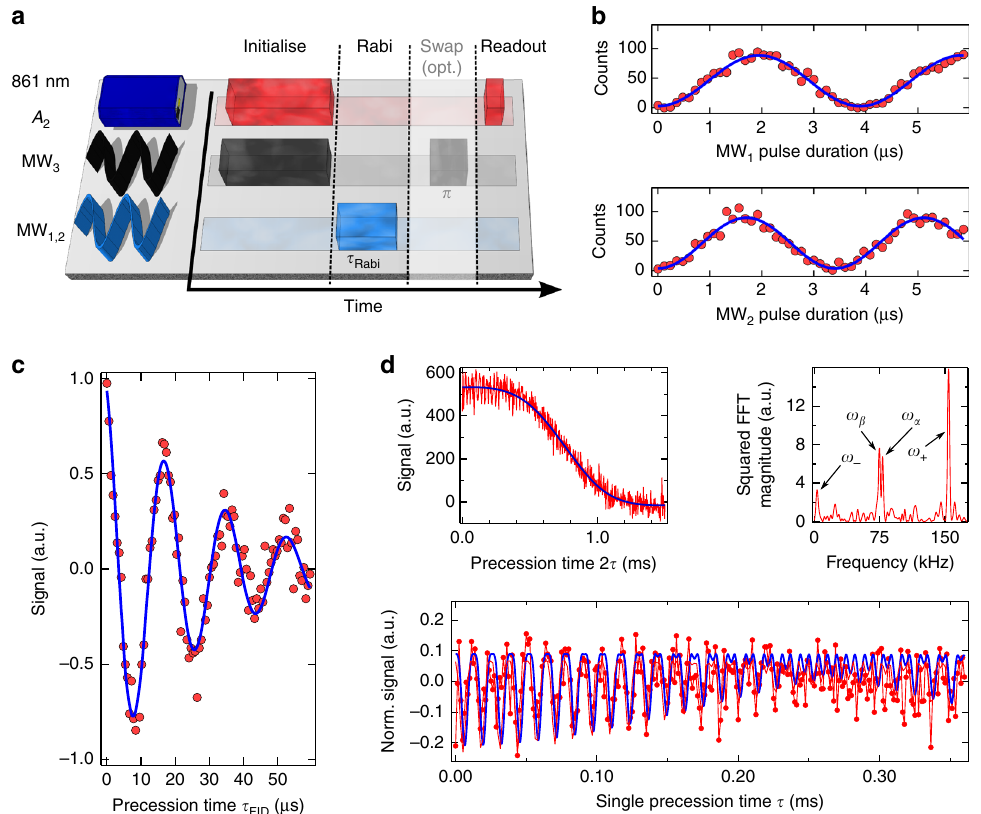
(cid:1) (cid:1) 2 (cid:1) (cid:1) 2 (lower panel). Blue lines are sinusoidal fi ts. All data are raw data. The gs ¼ 30 ± 2 μ s , and the blue line is a fi t. d Hahn echo 2